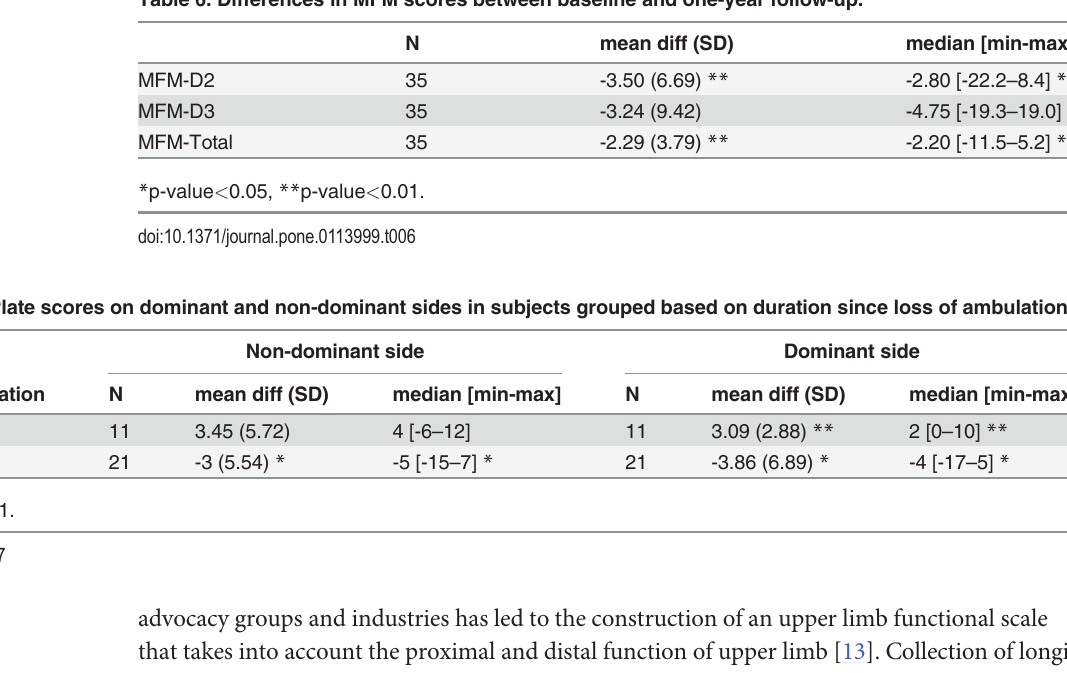
Table 6. Differences in MFM scores between baseline and one-year follow-up.